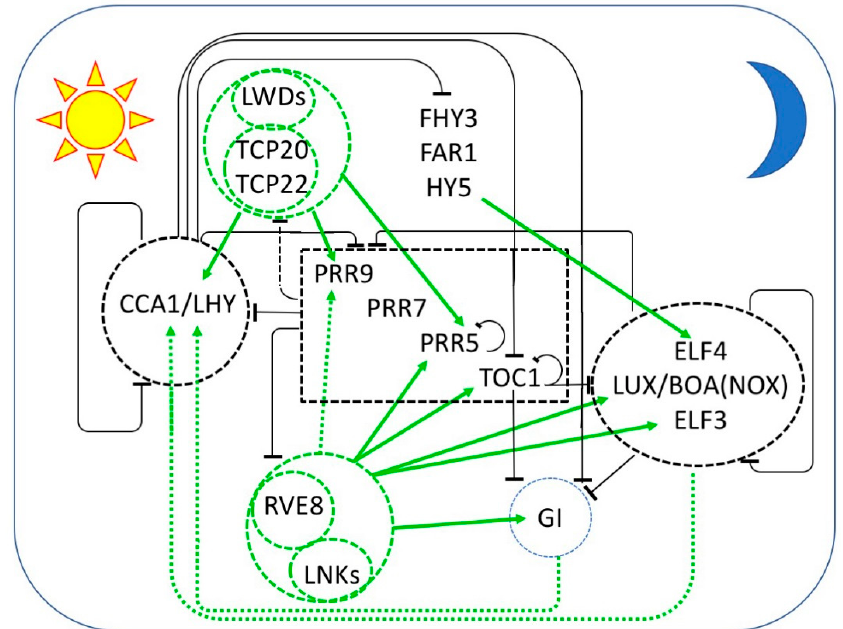
Figure 1. Multiple interlocked transcriptional feedback loops form the core of the circadian oscillator in Arabidopsis thaliana . The sequential expression of each component throughout the day/night cycle is shown from left to right, with the morning represented by the sun at the left and the night represented by the moon at the right. Black bars indicate repression and green arrows indicate activation of transcription. Protein complexes are enclosed by dashed lines. Transcriptional repressors are in black and repression is indicated by black bars. Transcriptional activators are in green and transcriptional activation is indicated by green arrows. Dashed arrows indicate relationships that are not established to be direct. At dawn, CCA1 and LHY repress the expression of the PRR genes, TOC1 , GI , and the EC members LUX , ELF3, and ELF4 . PRR9 , PRR7 , PRR5 , and TOC1 are sequentially expressed and repress the transcription of CCA1 and LHY , as well as their own transcription. LWD1 and LWD2 are transcriptional co-activators recruited to DNA by TCP20 and TCP22 to promote the expression of CCA1 , PRR9 , PRR7 , and TOC1 . In the afternoon, transcriptional activation is mediated by the LNKs, transcriptional coactivators recruited to DNA by RVE8 (and probably RVE4 and RVE6). RVE-LNK complexes promote transcription of PRR9 , PRR5 , TOC1 GI, LUX, and ELF4 . Additional transcriptional activation of ELF4 is provided by FHY3, FAR1, and HY5. In the evening, TOC1 represses all of the daytime components as well as GI , LUX , and ELF4 . LUX and ELF4 together with ELF3 form the evening complex (EC) which is a transcriptional repressor of GI, PRR9, and PRR7 . GI and an EC variant containing BOA (NOX) seem to be required for the transcriptional activation of CCA1 and LHY .